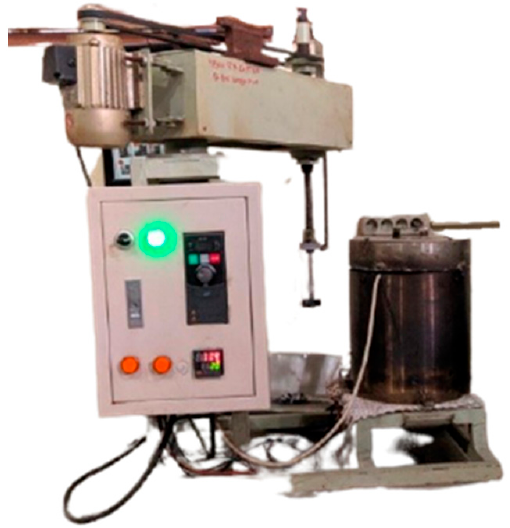
Figure 5. Stir casting setup.